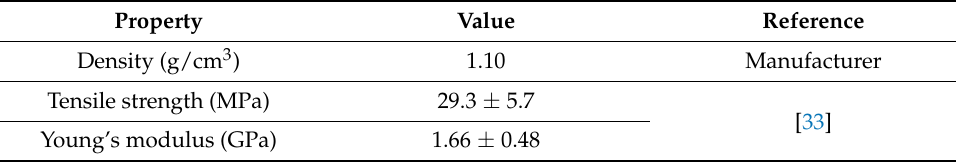
Table 2. The mechanical and physical characteristics of DGEBA/TETA